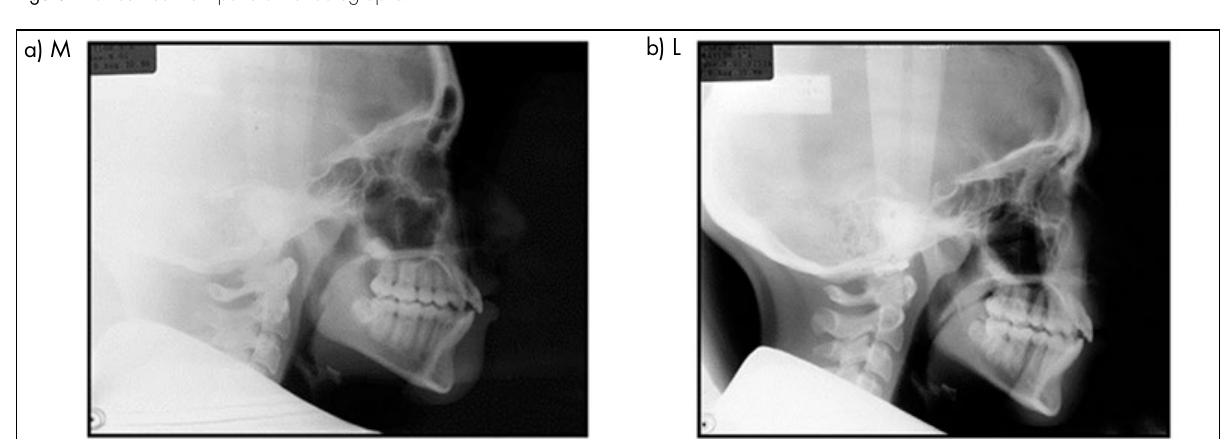
Figure 12. Post-treatment panoramic radiographs.